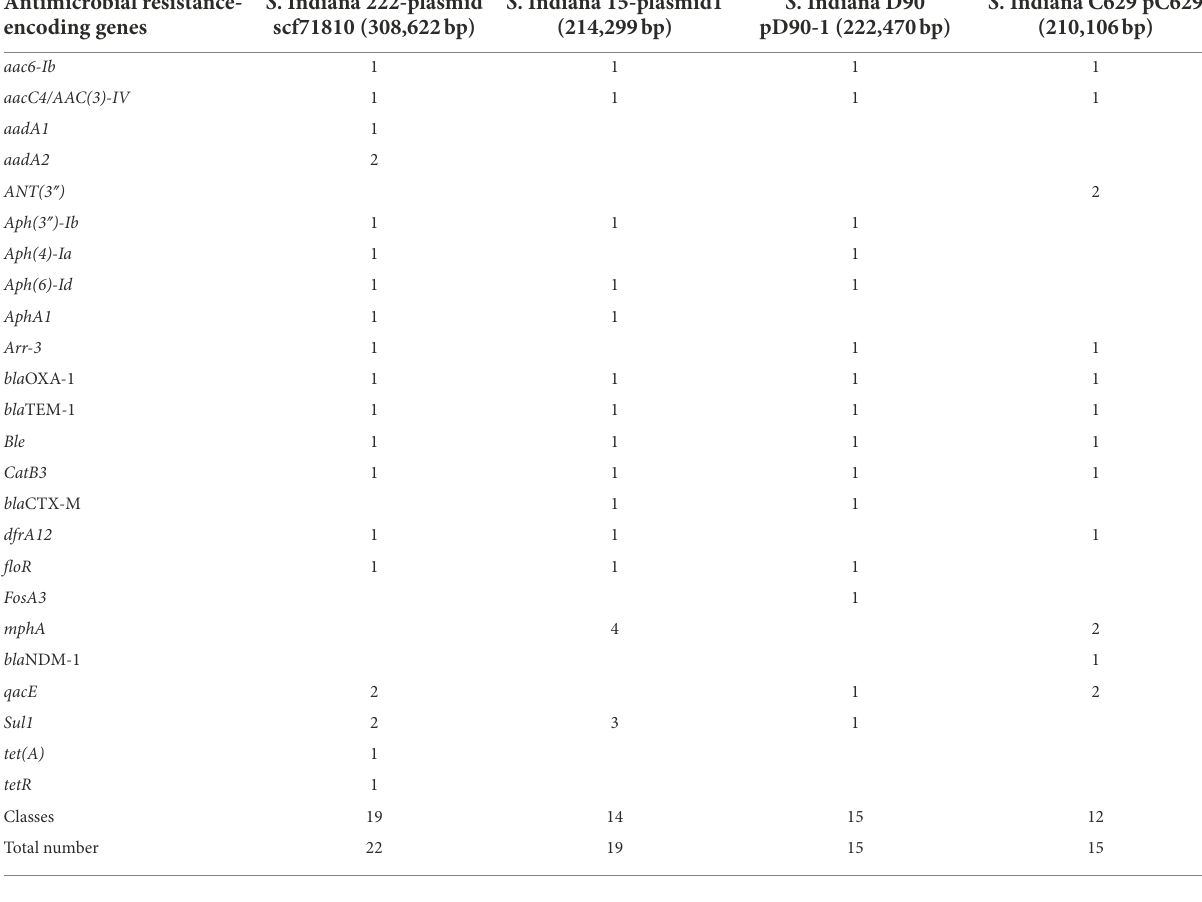
TABLE 2 Resistance genes of large plasmids of S . Indiana 15, S . Indiana 222, S . Indiana D90, and S . Indiana C629 isolates. Antimicrobial resistance- encoding genes